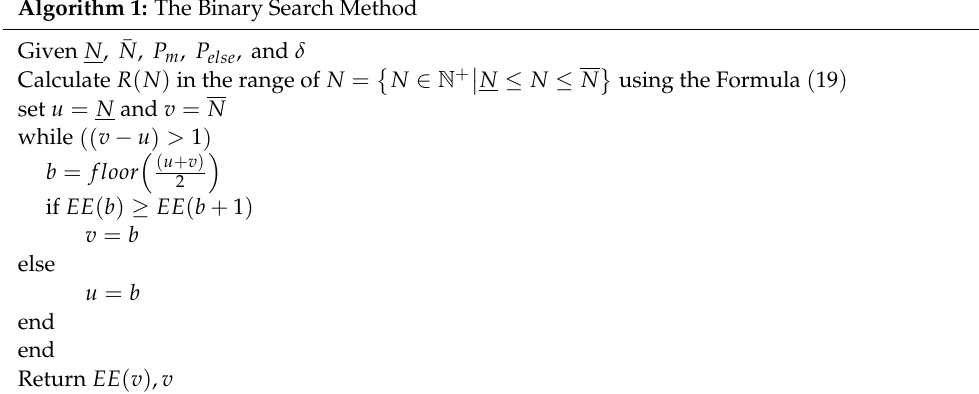
Algorithm 1: The Binary Search